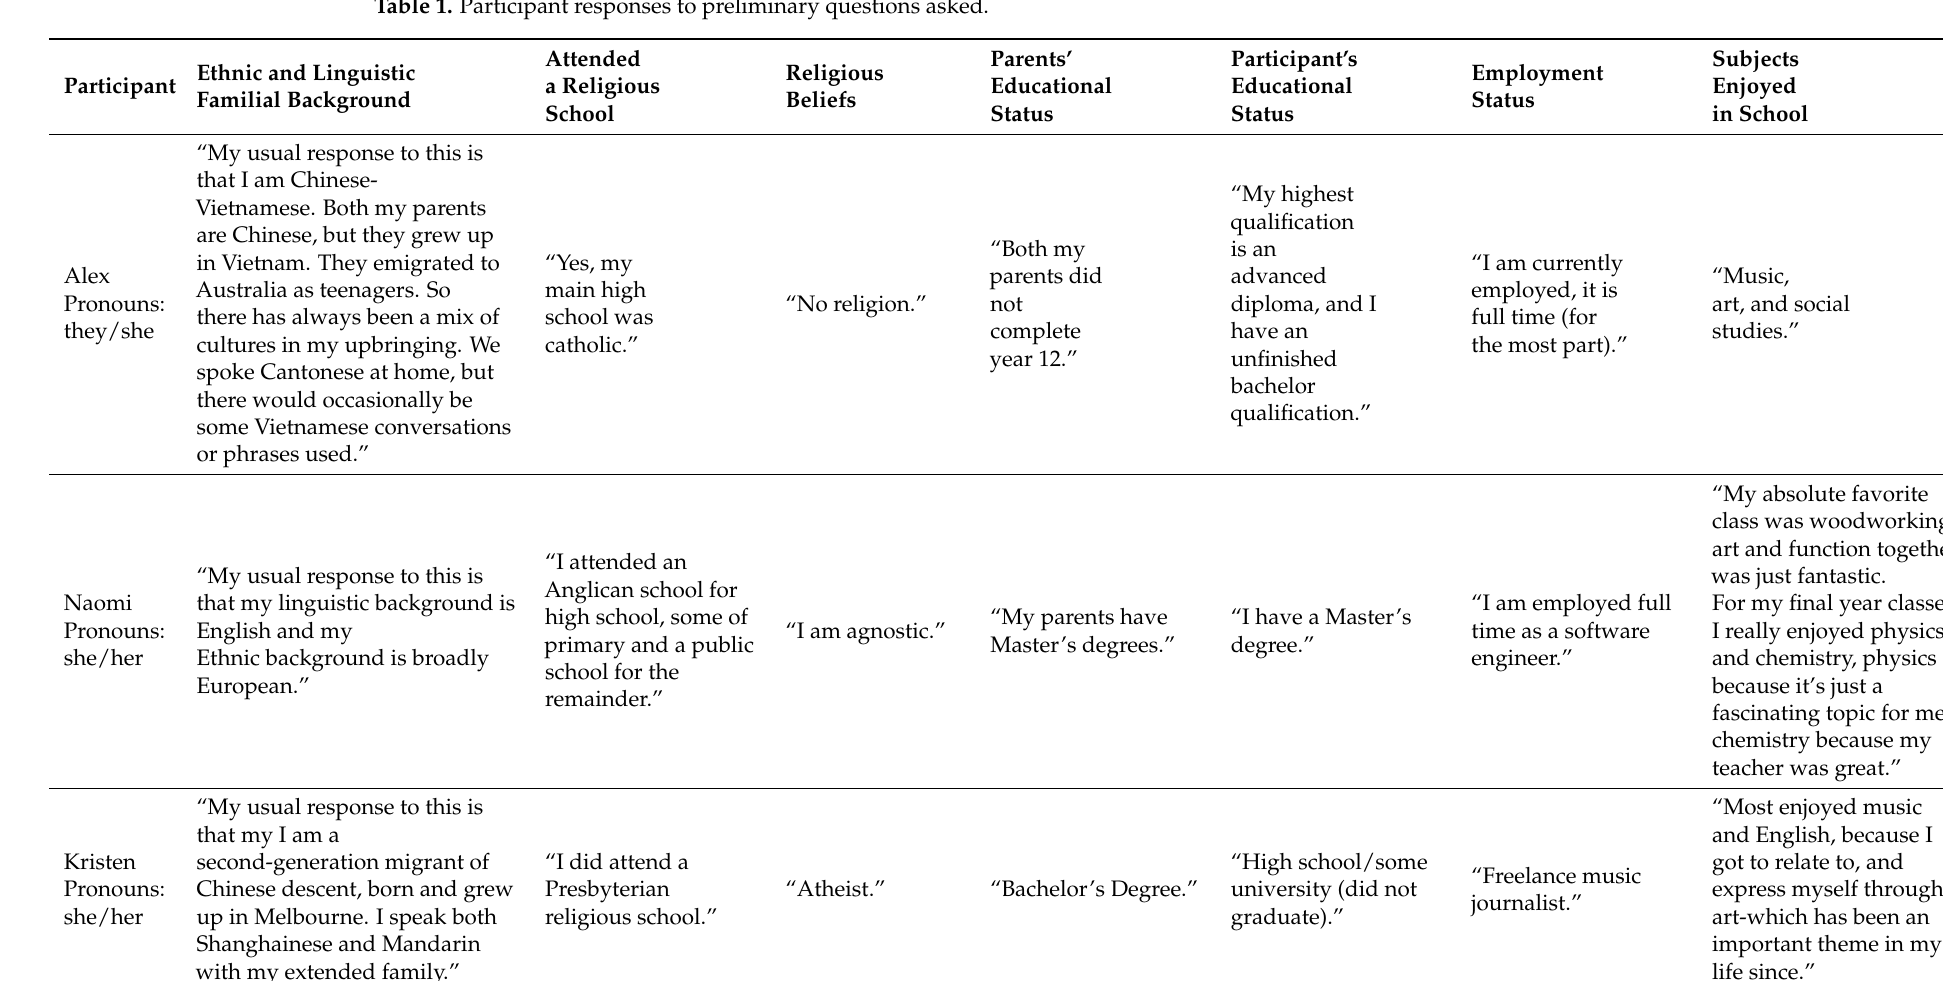
Table 1. Participant responses to preliminary questions